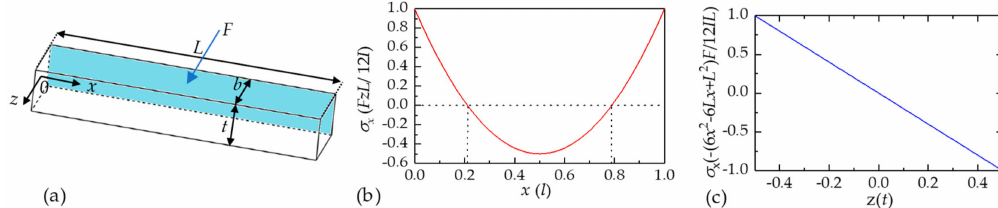
Figure 2. ( a ) The double-ends clamped beam used in theoretical analysis; ( b ) The curve of the axial stresses along the length direction; and ( c ) The curve of the axial stresses along the width